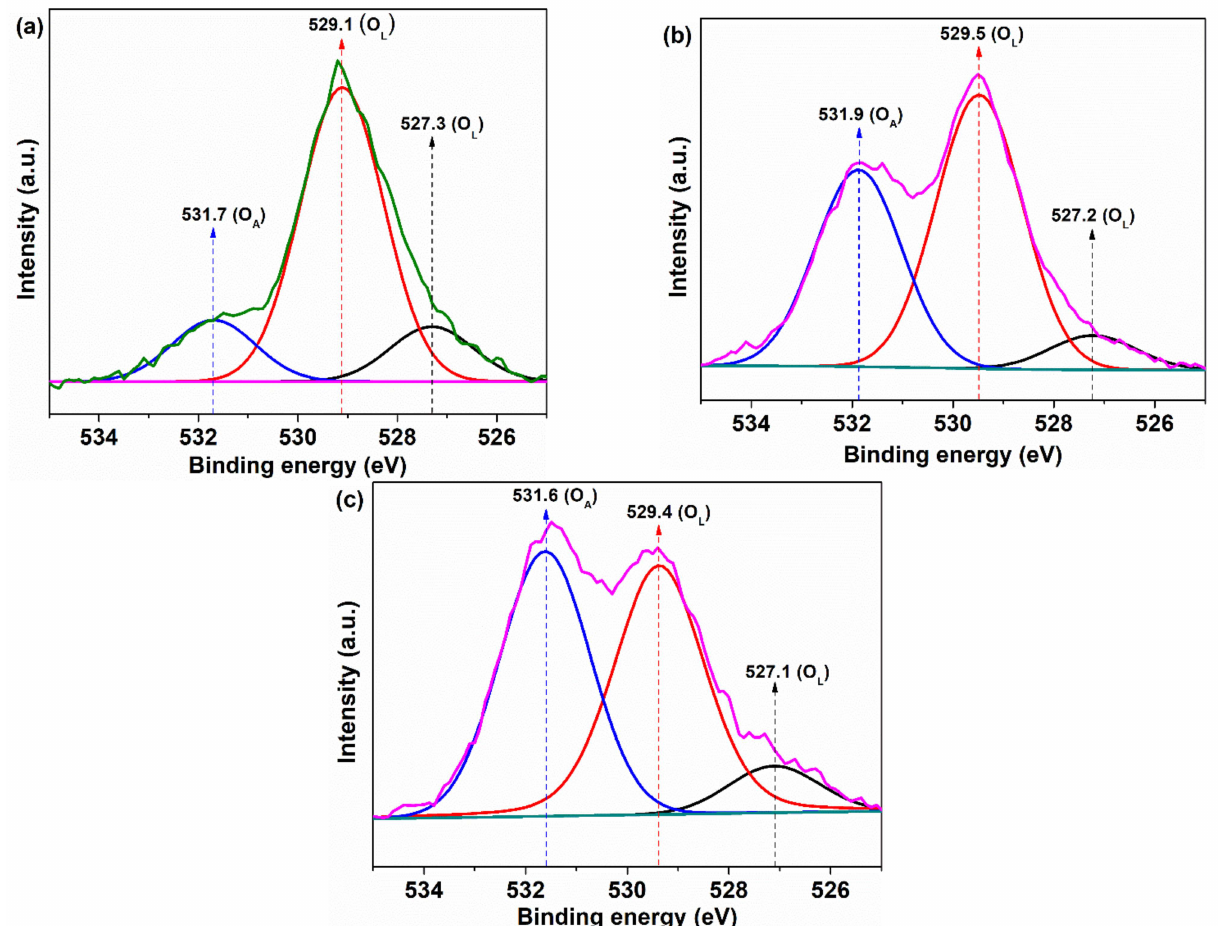
Figure 4. XPS of O 1s core-level of cerium oxide nanoparticles: ( a ) CeO-1, ( b ) CeO-2, and ( c )